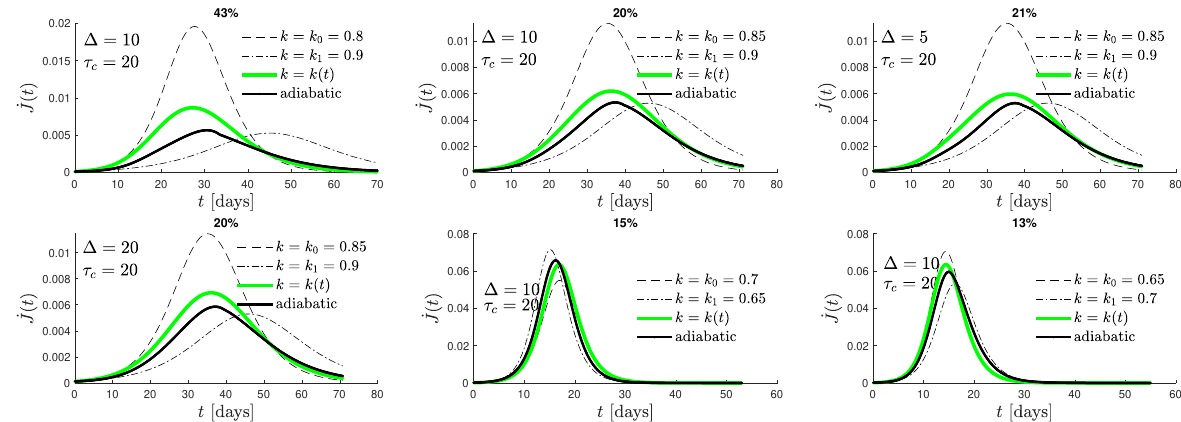
Figure 12. Daily new rate of infected persons, ˙ J ( t ) (43), versus real time t in the case of a constant recovery rate for the parameters from Figures 2–8. The adiabatic version IV (solid black line) is compared with the exact numerical solution (green) and the reference cases of constant k ( t ) = k 0 (dashed) and k ( t ) = k 1